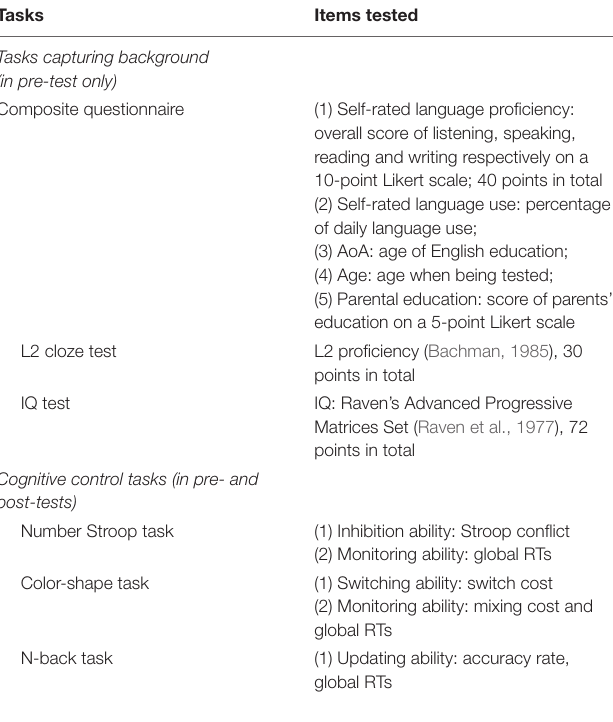
TABLE 3 | Summary of tasks used in the present study and description of the items tested. Tasks Items